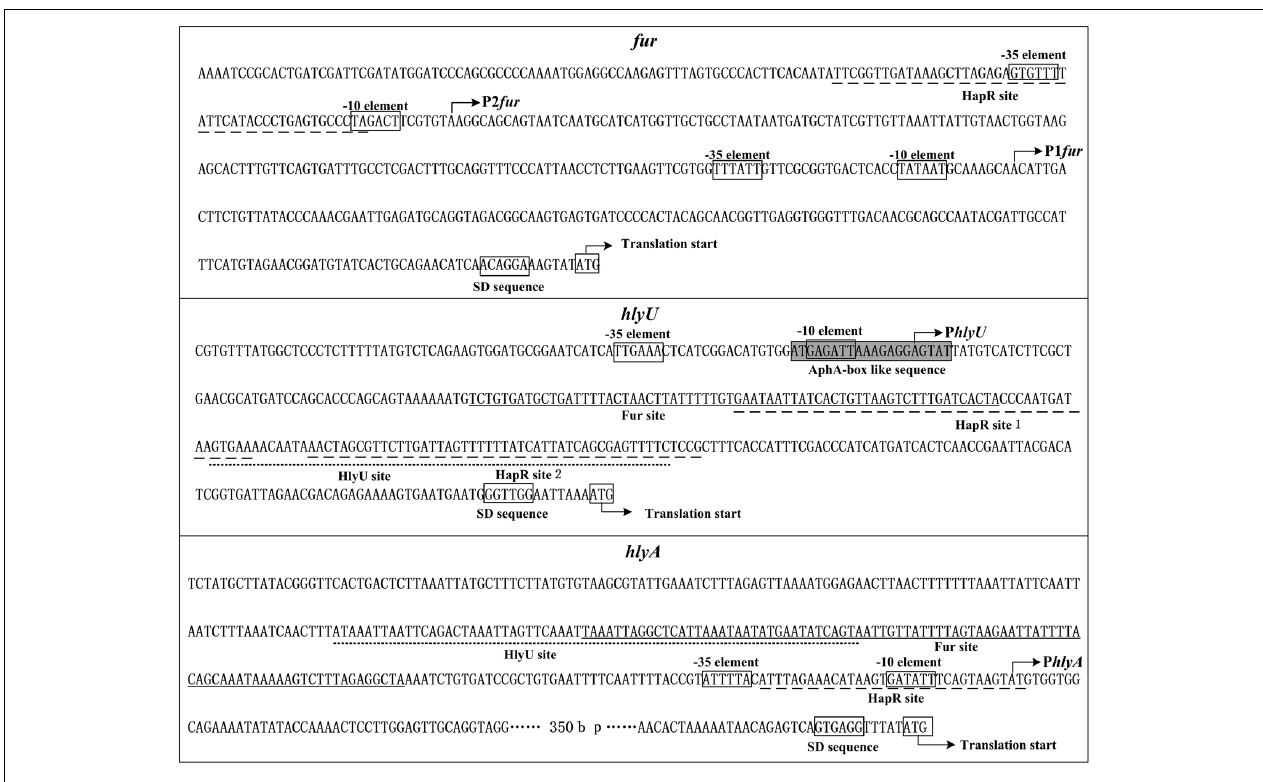
FIGURE 9 | Structural organization of target promoters. The DNA sequence was derived from Vibrio cholerae El Tor C7258. The transcription/translation start sites are indicated by bent arrows. Shine-Dalgarno (SD) box and –10/–35 elements are enclosed in boxes. The HapR sites are underlined with broken lines, the Fur sites are underlined with solid lines, while the HlyU sites are underlined with dotted